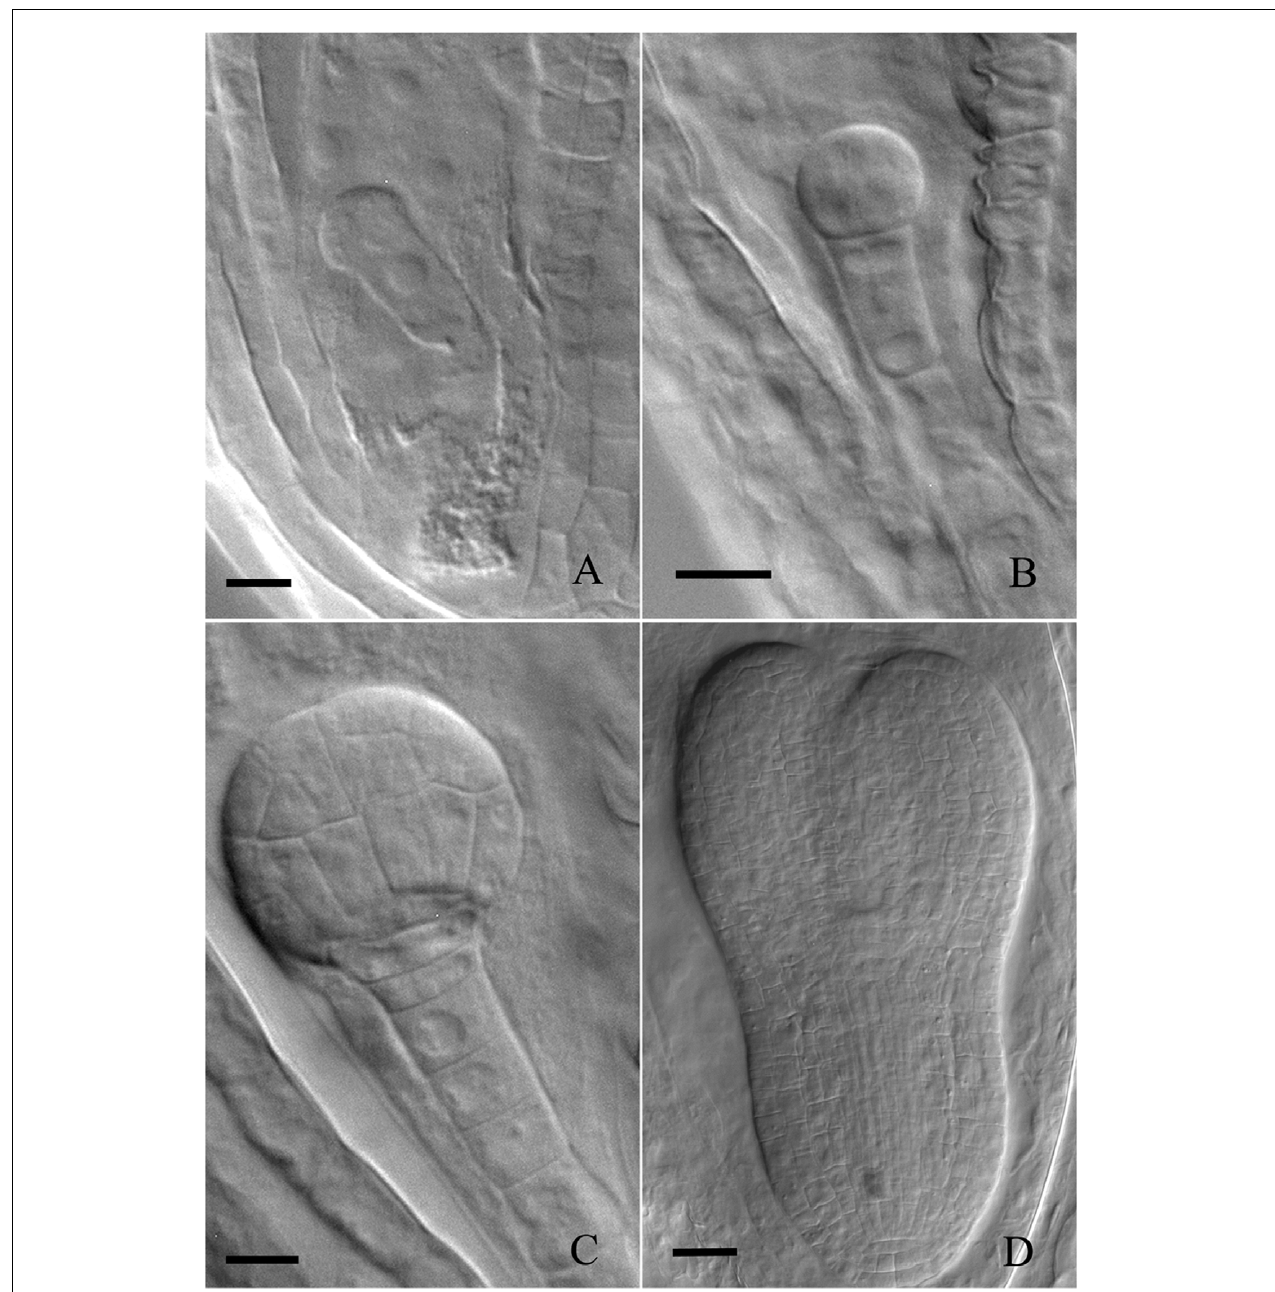
FIGURE 1 | Development of embryos from single-celled zygote to torpedo-shaped embryo. (A) Single-celled zygote grown under control conditions. (B) Two-celled embryo grown under control conditions. (C) Early globular embryo grown under control conditions. (D) Torpedo-shaped embryo grown under light deprivation. Bar = 20 µ